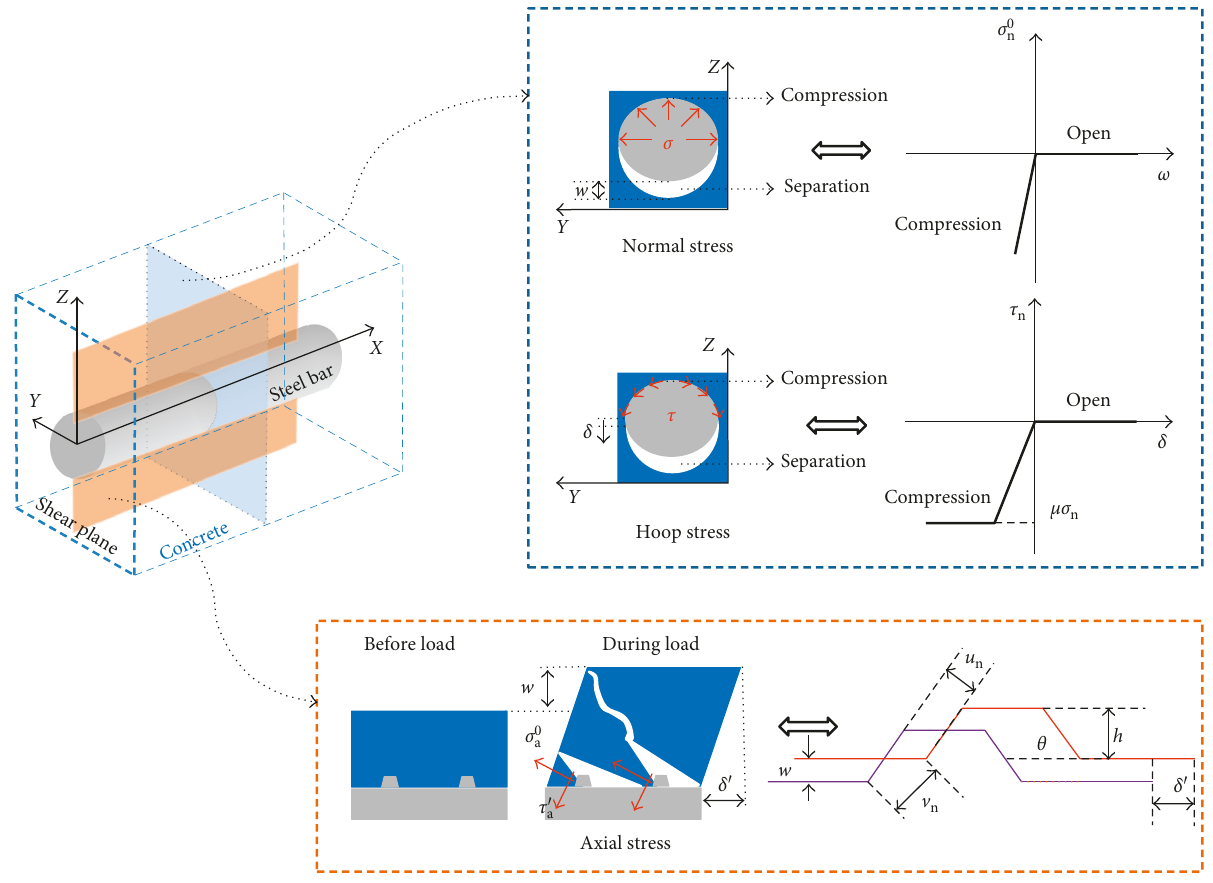
Figure 9: Modelling of the bond in the normal, hoop, and axial direction.